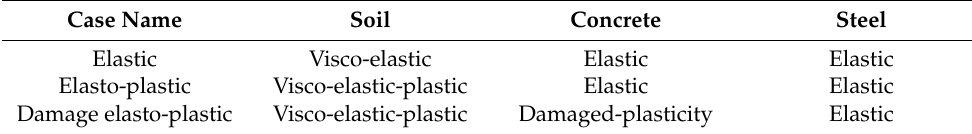
Table 3. Numerical cases for dynamic